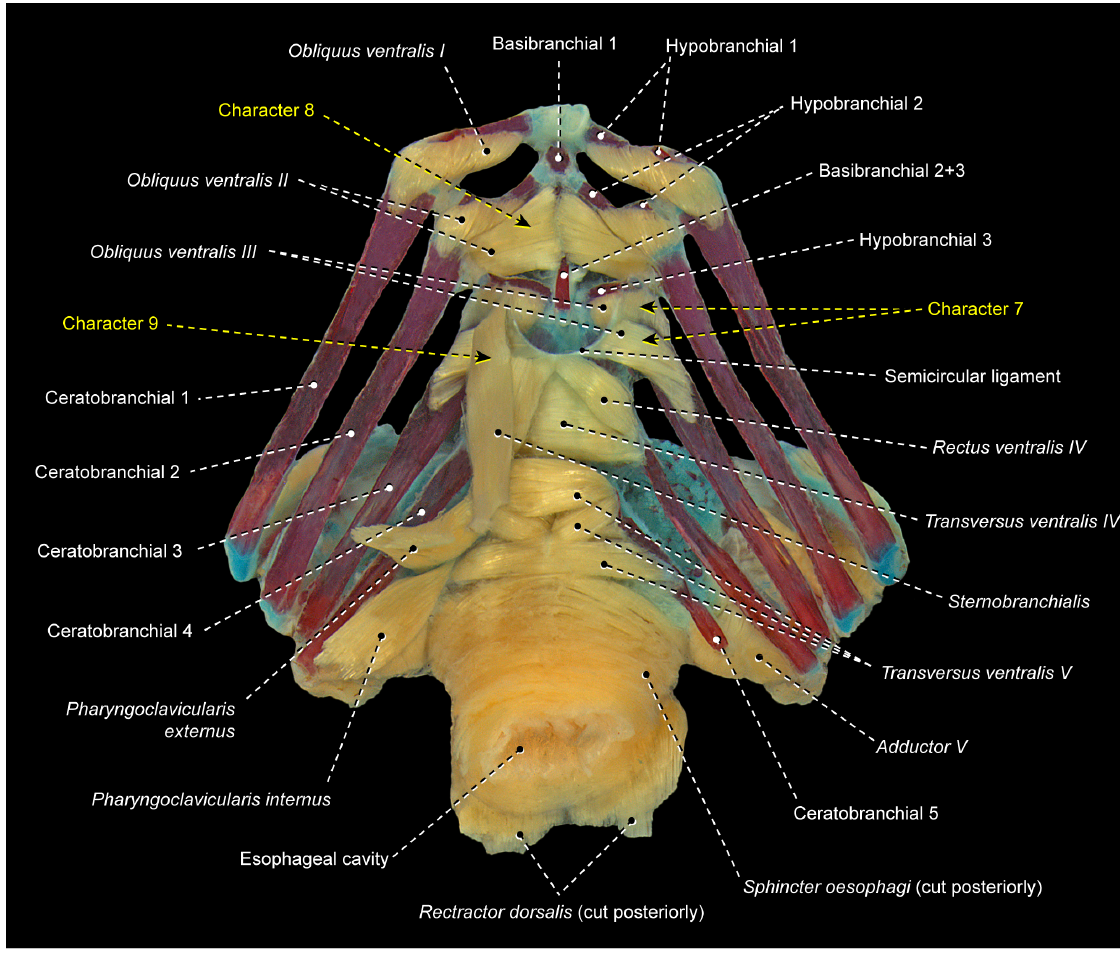
Figure 11. Branchial musculoskeletal system of Bathygobiussoporator (Gobiiformes: Gobiidae). MZUSP 66368. Ventral view; gill rakers, rectus communis , and left pharyngoclavicularis externus , pharyngoclavicularis internus , and sternobranchialis removed.